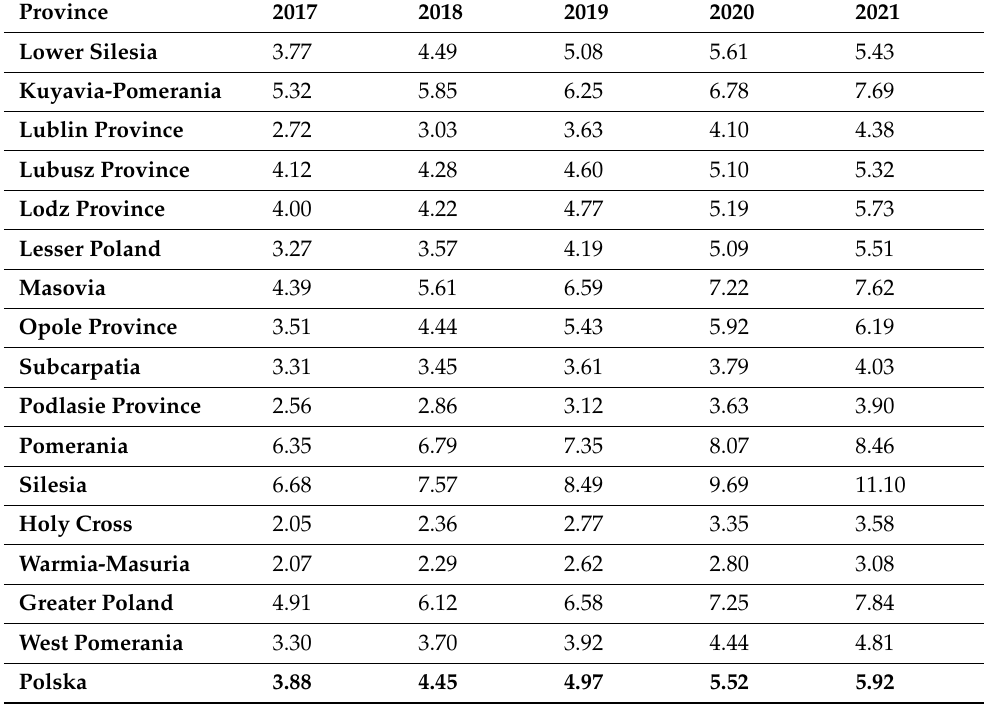
Table 7. Bicycle roads of Poland per 100 km 2 area in years